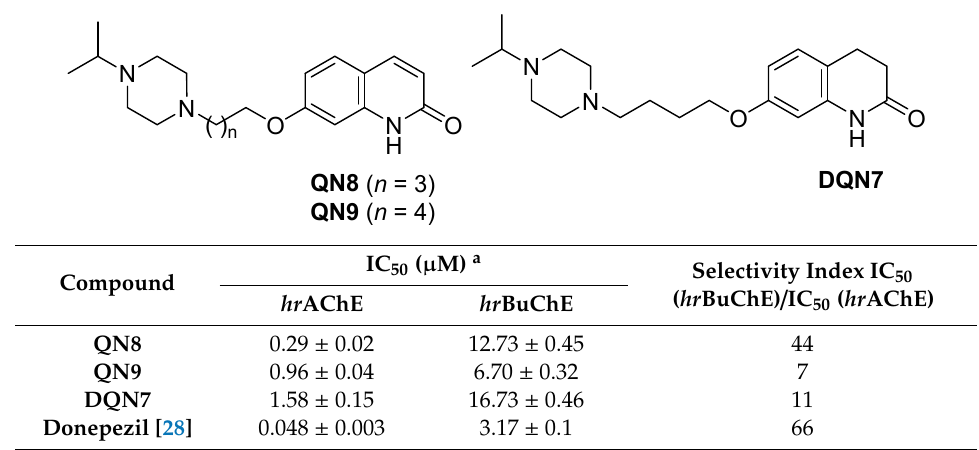
Table 1. Determination of IC 50 for human recombinant acetylcholinesterase ( hr AChE) and